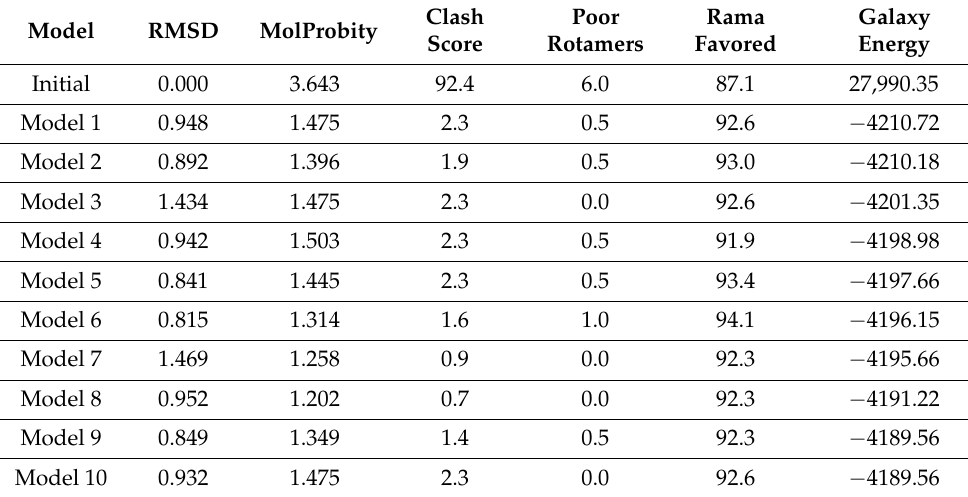
Figure 6. Left side picture represents wild type structure while right side picture represents mutated structure. Table 3. Pairs of amino-acid residues Chi-3 values and energy.